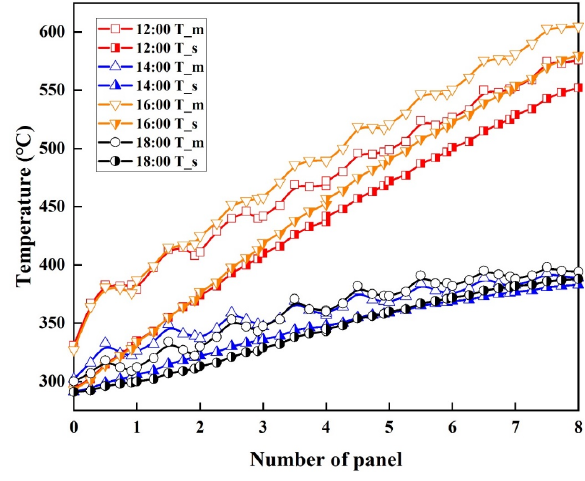
Figure 6. The temperature distribution at a specific time.